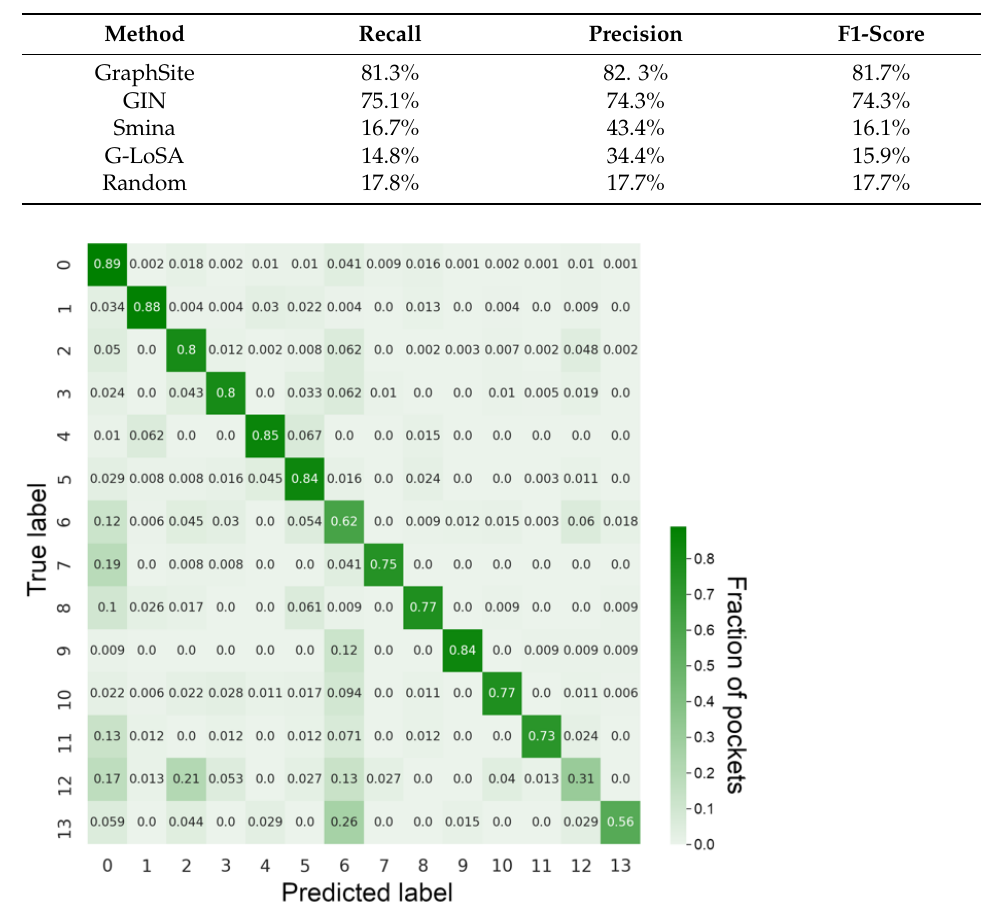
Table 2. Classification performance against the benchmarking dataset. GraphSite is compared to the graph isomorphism network (GIN), molecular docking with smina, pocket matching with G-LoSA, and a random classifier. Precision, recall, and F1-score are class-weighted.